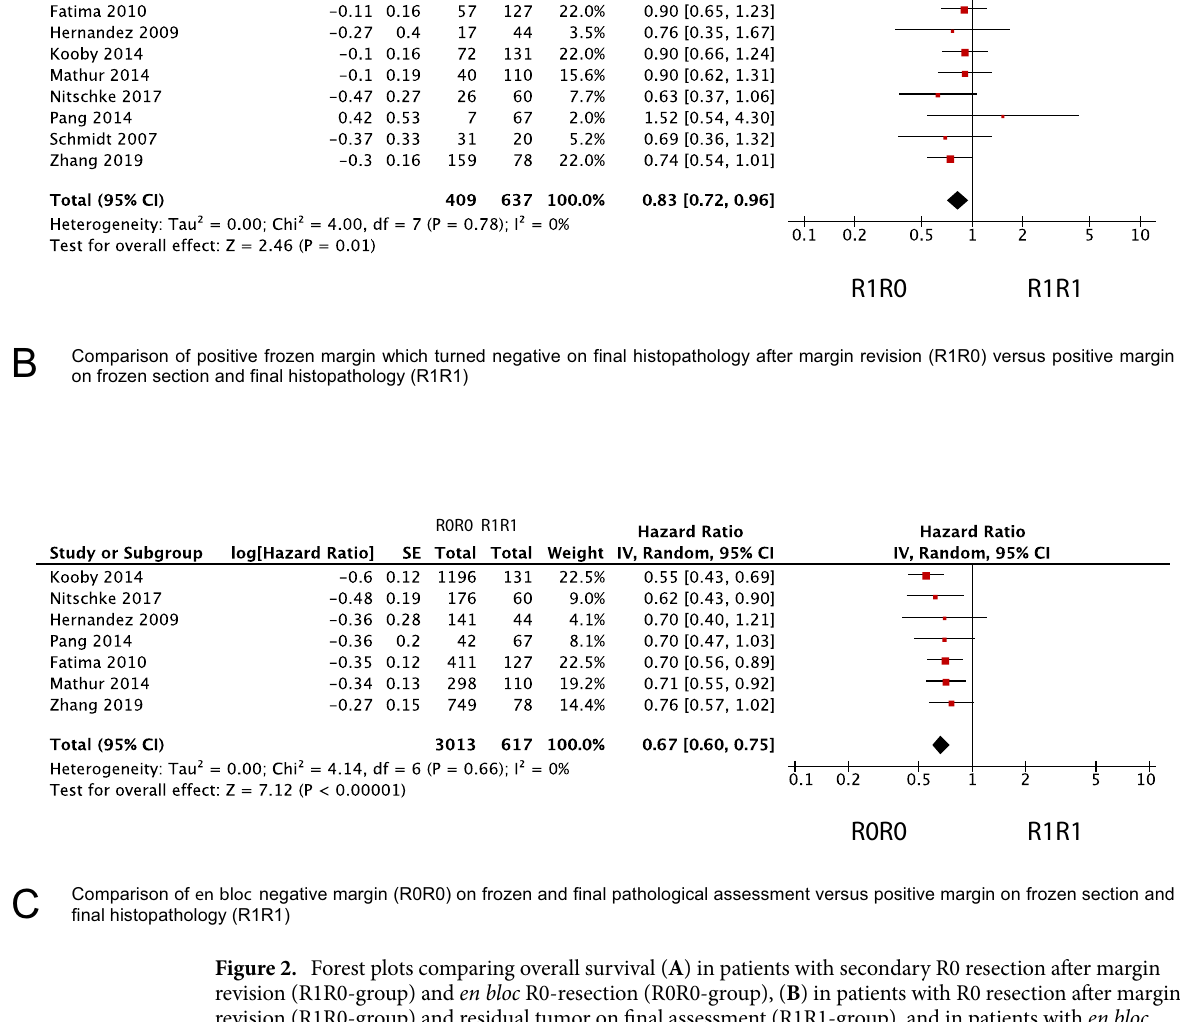
Figure 2. Forest plots comparing overall survival ( A ) in patients with secondary R0 resection after margin revision (R1R0-group) and en bloc R0-resection (R0R0-group), ( B ) in patients with R0 resection after margin revision (R1R0-group) and residual tumor on final assessment (R1R1-group), and in patients with en bloc R0-resection (R0R0-group) and residual tumor on final assessment (R1R1-group) . An inverse variance random effects model was used for meta-analysis. Squares and horizontal bars indicate point estimate (hazard ratios) with 95% CI for the individual